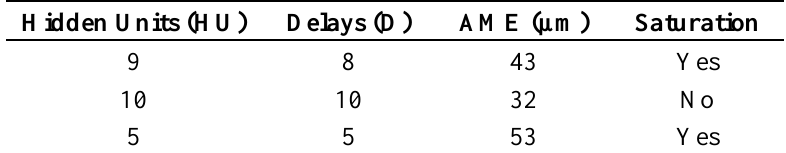
Table 1. Summary of the fine tuning results.